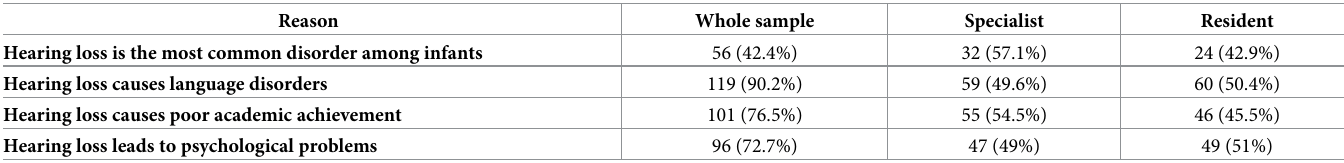
Table 4. Reasons reported by family physicians explained why the early detection of hearing loss is particularly important for